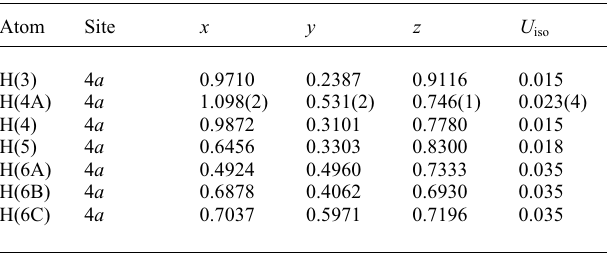
Table 2. Atomic coordinates and displacement parameters (in Å 2 ) ..